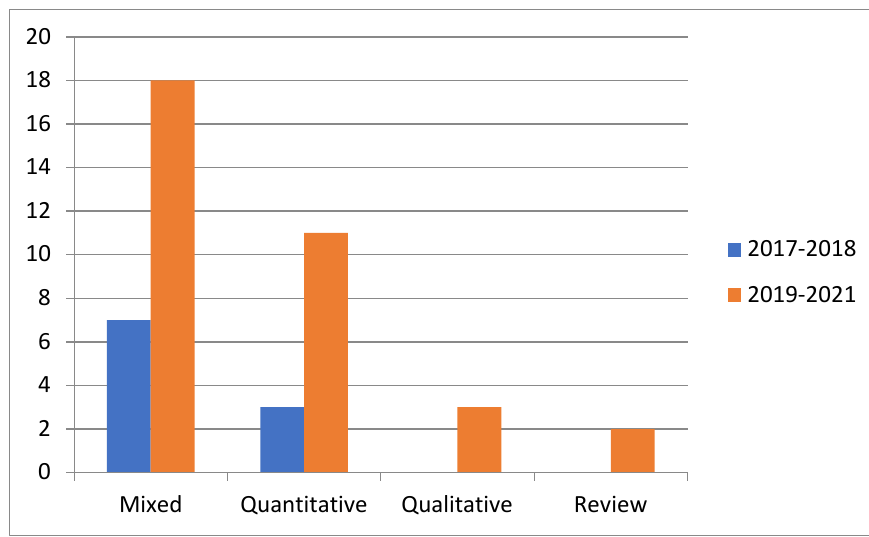
Figure 1. Trend in types of research design used between 2017 ‐ 2018 and 2019 ‐ 2021.